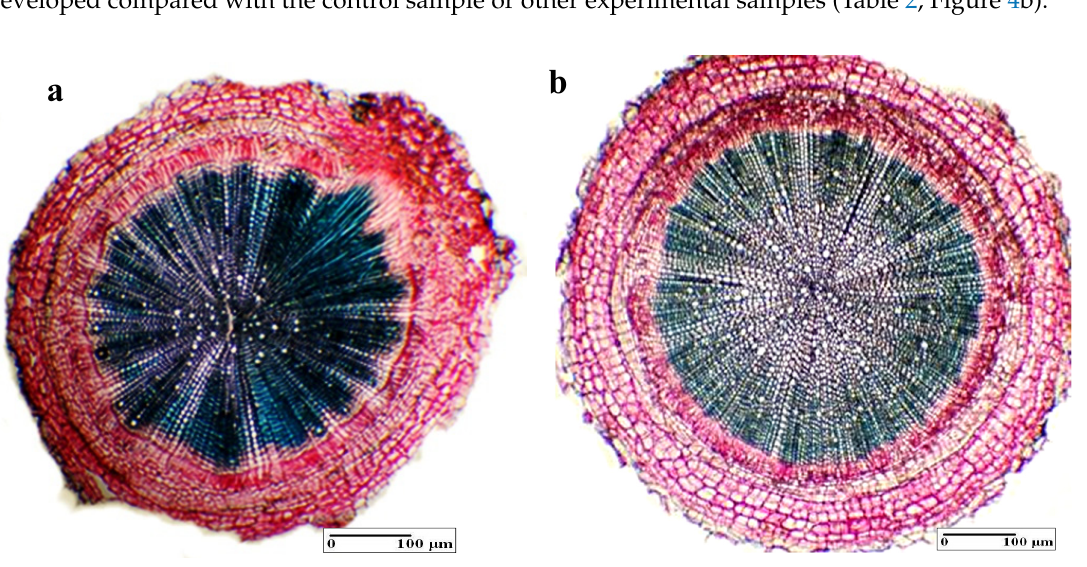
Table 1. Content of photo-assimilatory pigments synthesized (mg/g) in lemon balm leaves.